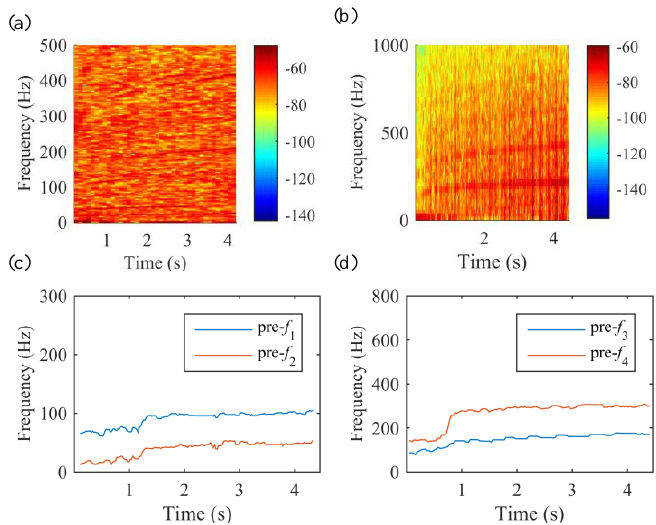
Figure 8. Outer race fault case: ( a ) TFR of lower frequency band signal, ( b ) TFR of envelope of resonant frequency band signal, ( c ) extracted IF ridges from ( a ) using FPO, and ( d ) extracted IF ridges from ( b ) using FPO.